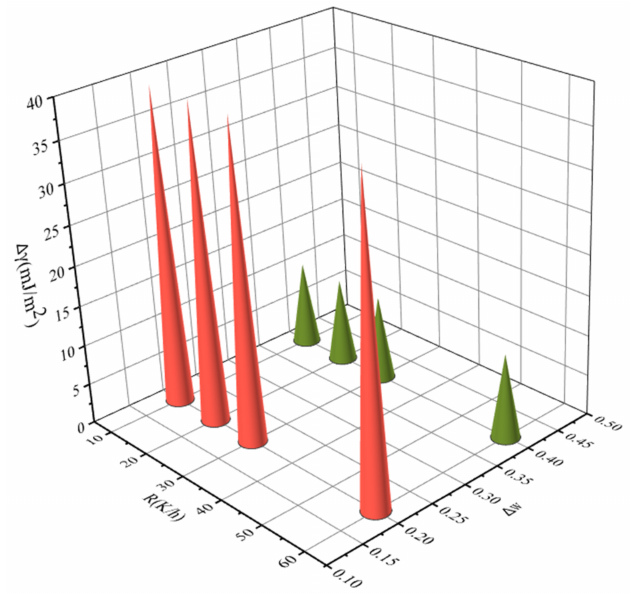
Figure 15. The relationship between interfacial energy γ and the change in ethanol mass fraction (saturated temperature 293.15 K, cooling rate 10, 20, 30, and 60 K/h,